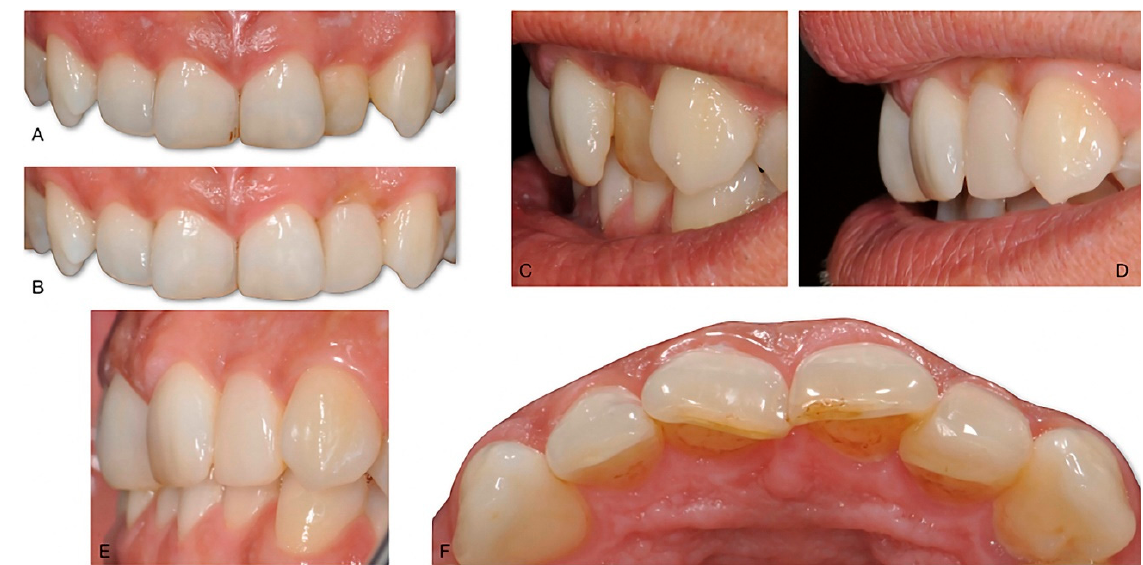
Figure 7. A 37-year-old woman. The 2.2 is tilted towards the palate ( A,C ). This tooth, set back compared to the other elements of the front group, is more difficult to manage in home hygiene. Even the self-cleansing mechanisms work worse, and for these reasons, the tooth quickly becomes darker, and creates great discomfort for the patient, who is not willing to undergo orthodontic treatment. The BAIR technique represents an alternative, quick, and possibly reversible solution, with no biological cost, and an immediately visible result ( B,D ). It is possible to obtain a remarkable change of the emergence angle in the intrasulcular portion of the restoration, which allows for the reshaping of a lateral incisor congruent with the contralateral one. The follow-up shows a stable result ( E ), and the treated tooth shows an increased thickness ( F ) that does not cause any discomfort for the patient (it should also be considered that the occlusal relationships have not been modified).